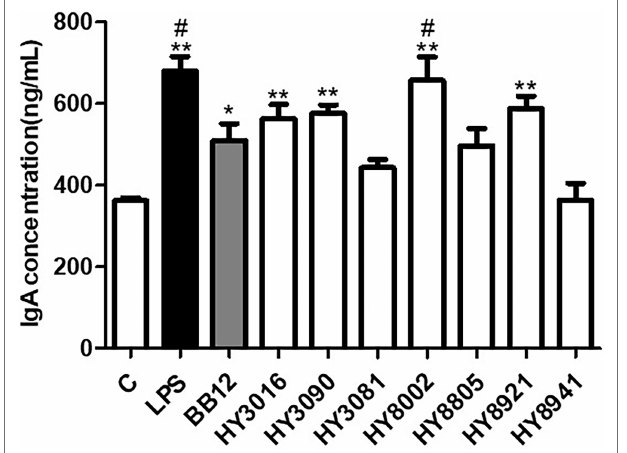
FIGURE 3 | Effect of Bifidobacterium strains on immunoglobulin A (IgA) production by Peyer’s patch cells. Lipopolysaccharide was used as the positive control for induction of IgA secretion. The IgA concentration in the culture media was determined by ELISA. Each value is expressed as the means ± SEM of three independent experiments. * p < 0.05 and ** p < 0.01 in comparison with the untreated control. # p < 0.05 compared with BB12